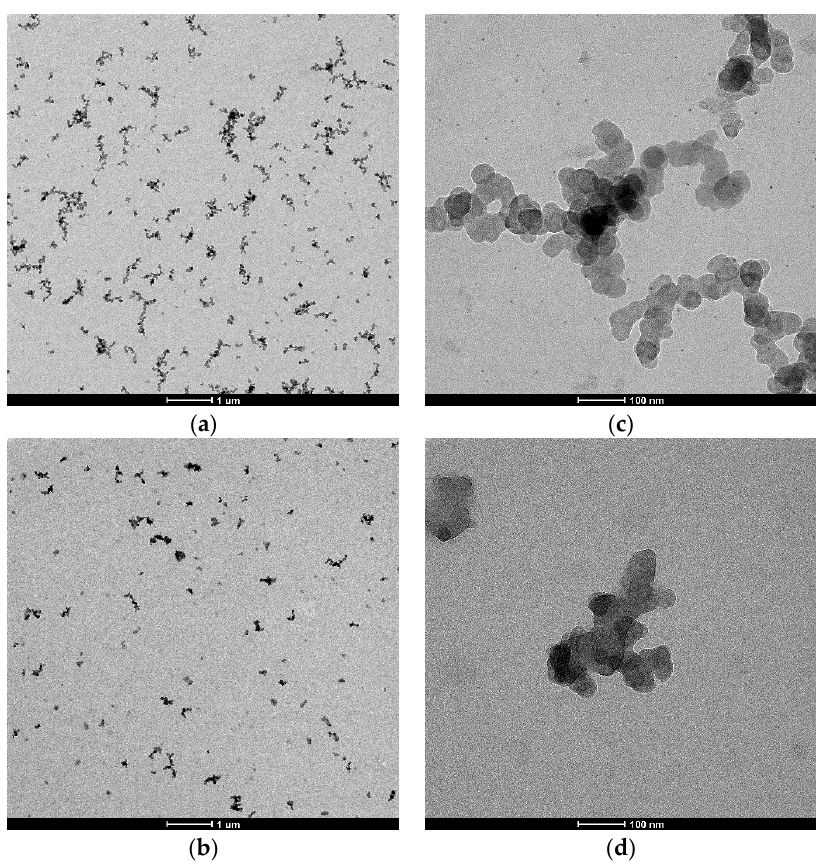
Figure 10. TEM images of soot sampled at a 40 mm height after the burner ( a ) kerosene flame soot (case 4); ( b ) CO 2 ‐ diluted kerosene flame soot (case 6) at magnification of 7000; ( c ) kerosene flame soot; ( d ) CO 2 ‐ diluted kerosene flame soot at higher magnification of 74,000. Table 2. Composition analysis of soot samples collected at a 40 ‐ mm height above the burner.